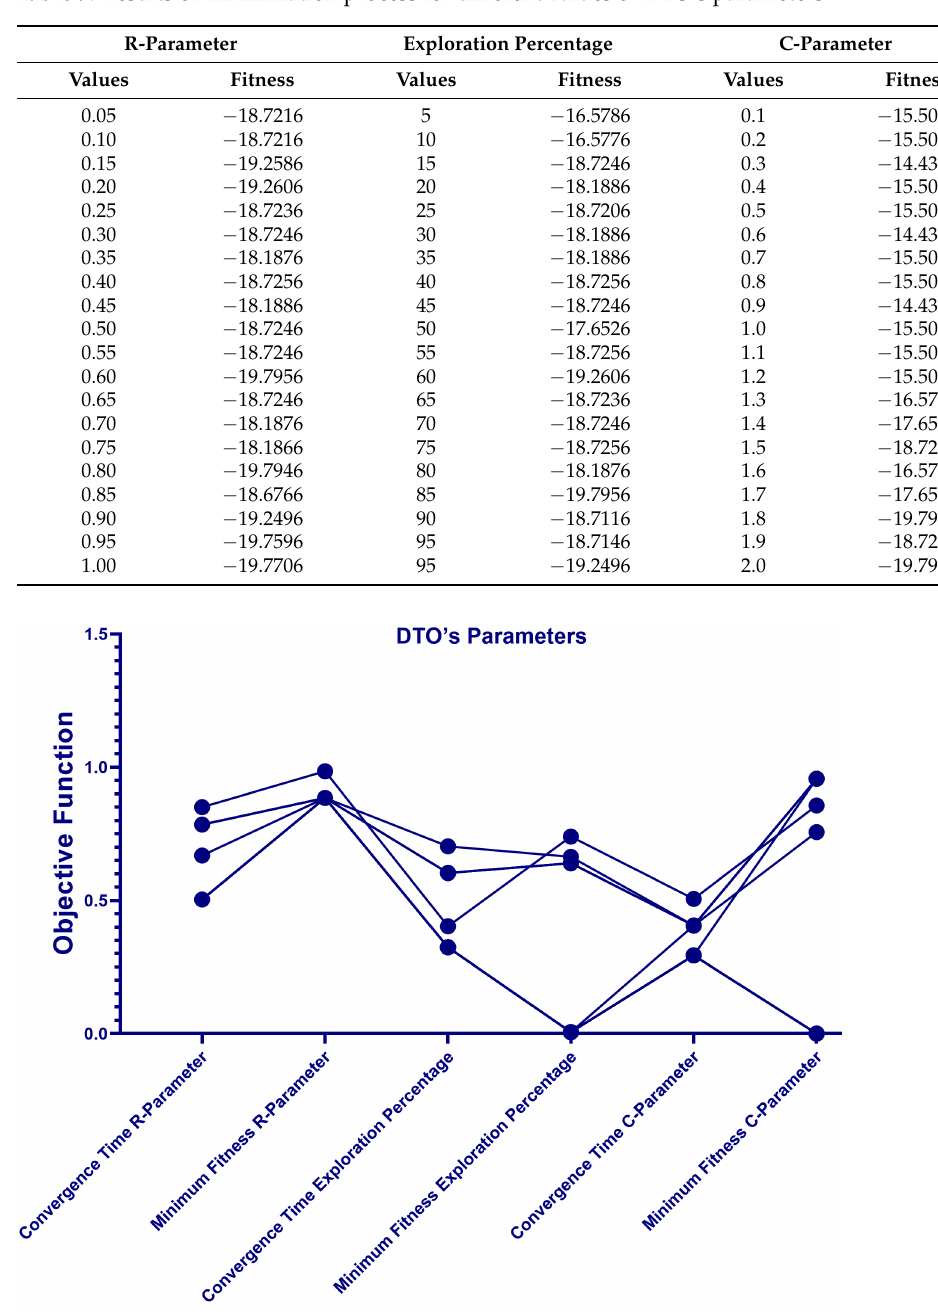
Table 9. Results of minimization process for different values of DTO’s parameters.